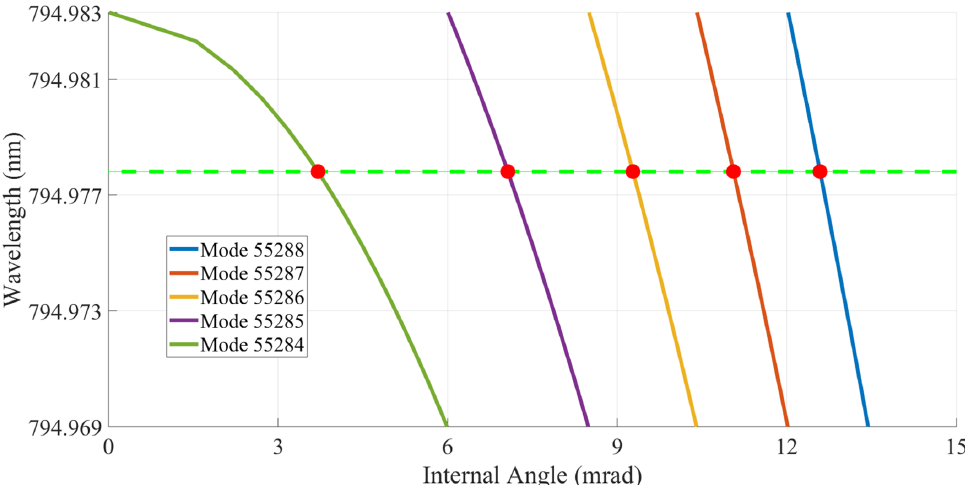
Figure 11. The red points are plotted to mark the angle at which each etalon mode coincides with the resonance line of 87 Rb D1 line F = 2 state. This calculation is done for a room temperature corresponding to 23.4 ◦ C. These points directly aligned to the F = 2 fluorescence peaks in Figure 10a. The plotted curves depict the frequency sweep of each etalon mode as the internal angle of the etalon is tuned. The green dashed line marks the value of the F = 2